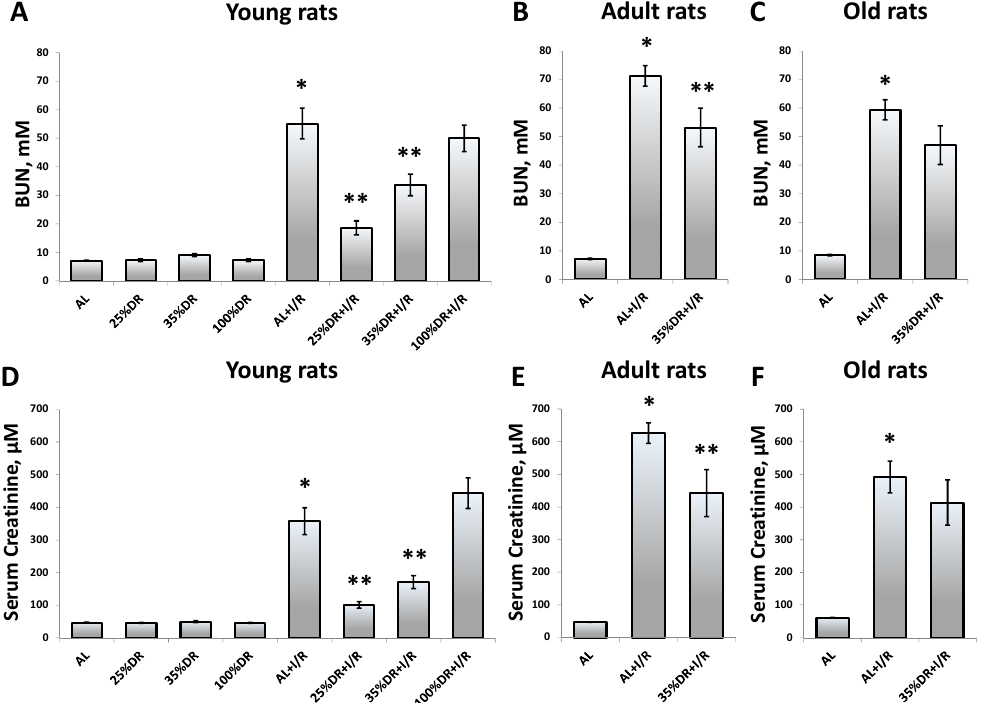
Figure 1. The evaluation of kidney function by the blood urea nitrogen (BUN) and serum creatinine (SCr) in young, adult, and old rats kept on an ad libitum (AL) diet or using different protocols of dietary restriction (DR). ( A ) Assessment of renal function in young (3–4 months) control days (100% DR). Evaluation of the severity of acute kidney injury (AKI) in these groups of rats 48 hours after I/R; ( B ) Assessment of kidney function and severity of AKI 48 hours after I/R in adult (12 months) rats; ( C ) Assessment of kidney function and severity of AKI 48 hours after I/R in old (20–23 months) rats; ( D – F ) Evaluation of SCr concentration in young, adult, and old rats on AL or DR 48 hours after I/R. Control groups contained more than 3 rats, while groups with I/R included more than 6 rats. * p < 0.05 compared to AL, ** p < 0.05 compared to AL + I/R.